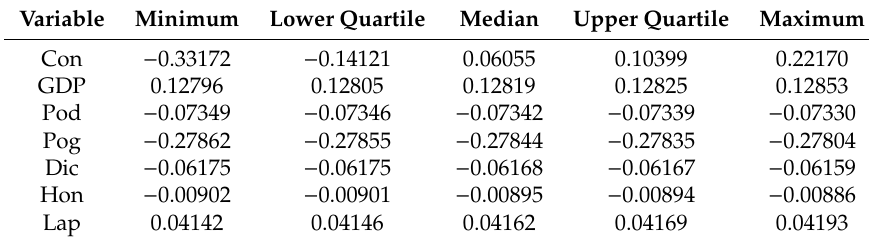
Table 4. Descriptive statistics by GWR.